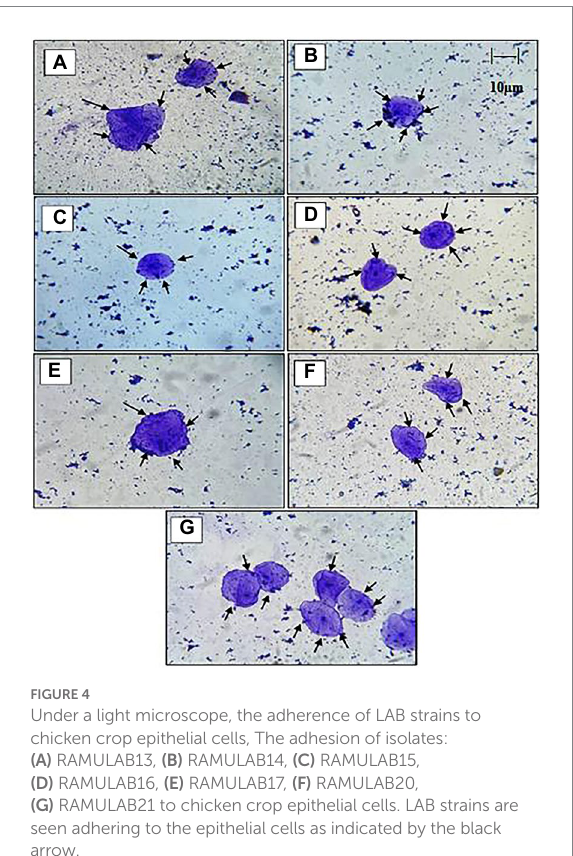
FIGURE 3 The autoaggregation (%) (A) and coaggregation (B) of LAB strains at different time intervals and 2 h incubation at room temperature. *Data are presented as mean ± standard deviation. Duncan’s multiple range tests revealed that the means of the survival rate with a 24 h time interval and superscripts (a–e) are substantially different from one another ( p ≤ 0.05).